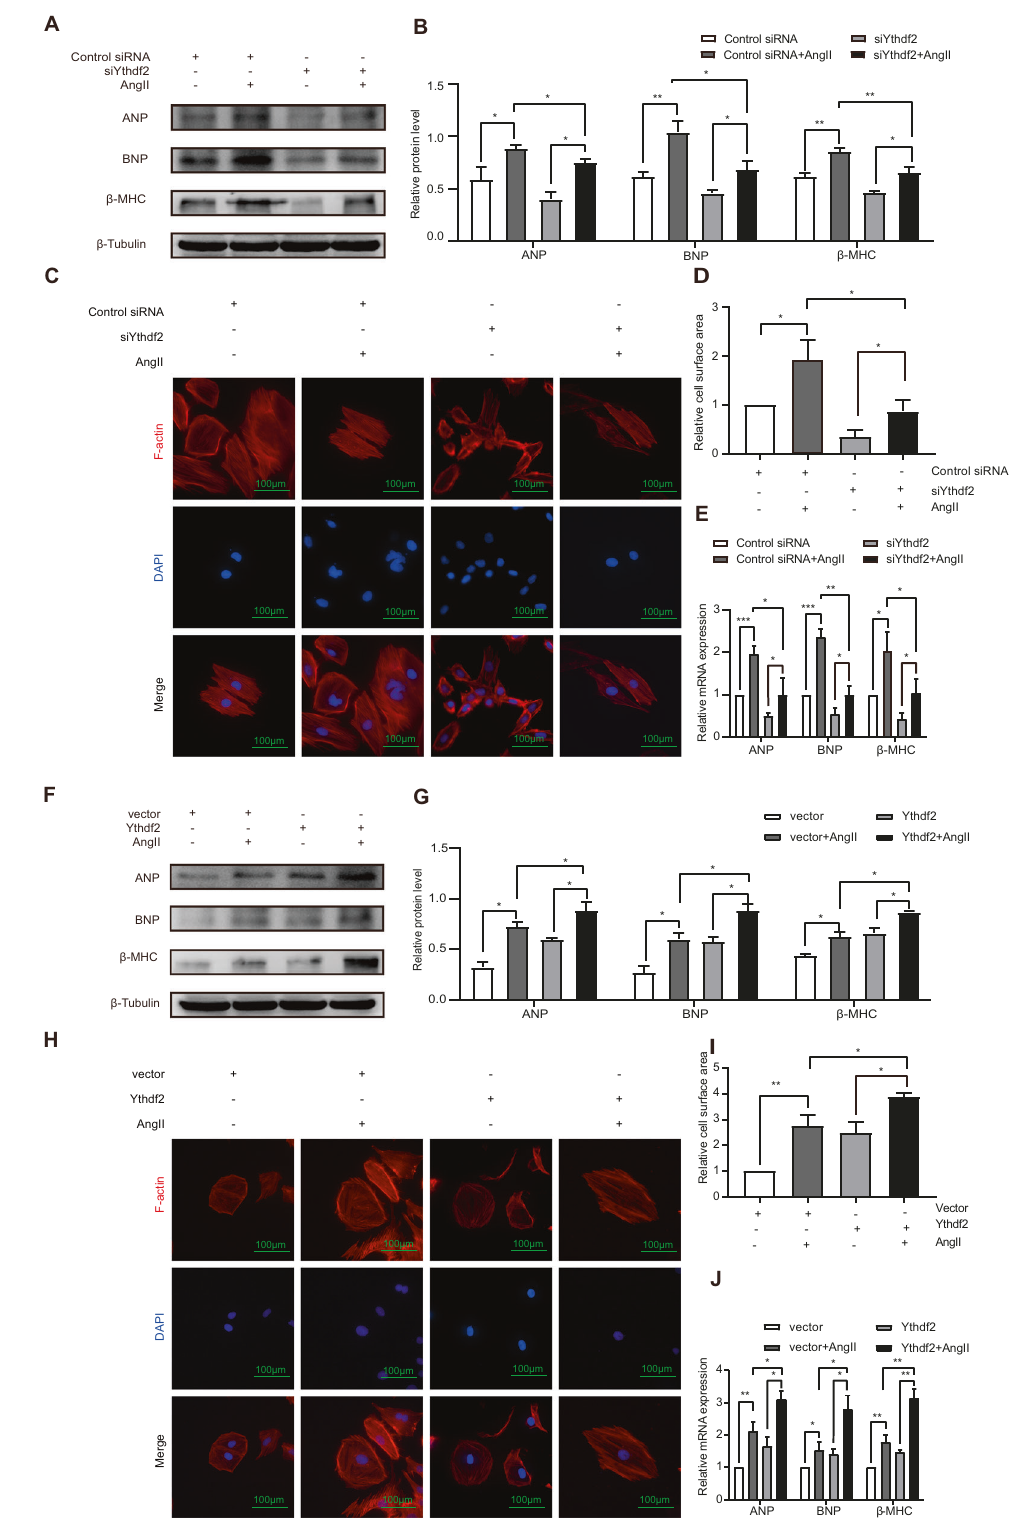
hypertrophy phenotype of AngII-treated H9c2 cells. To further con fi rm the promoting role of Ythdf2 in H9c2 cardiac hypertrophy phenotype, phalloidin staining showed that AngII increased the cell surface area in H9c2 while Ythdf2 knockdown signi fi cantly inhibited cardiac hypertrophy following